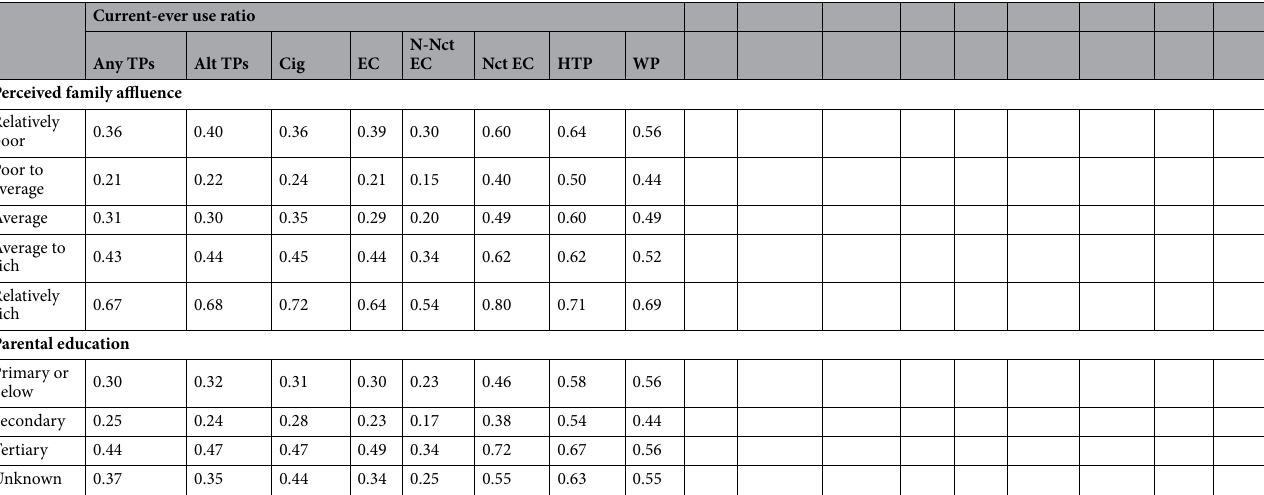
Table 1. Use of various tobacco products in Hong Kong secondary school students by sociodemographic factors. All percentages were weighted by sex, age, and grade distribution of the underlying population provided by the Education Bureau of the Hong Kong Special Administrative Region Government. TP, tobacco product; Alt TP, alternative tobacco product; Cig, cigarette; EC, e-cigarette; N-Nct, non-nicotine; Nct, nicotine; HTP, heated tobacco product; WP, waterpipe.